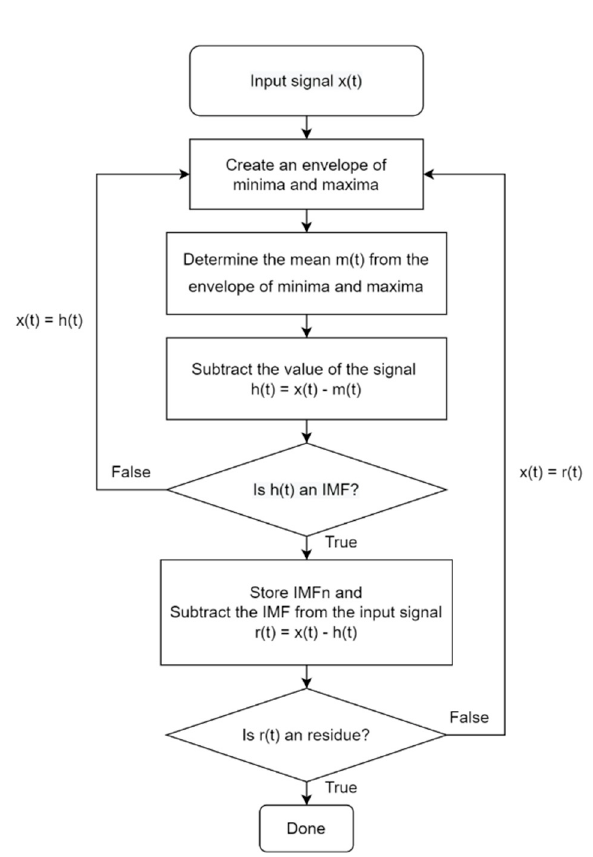
Figure 1. A flowchart of sifting processes.